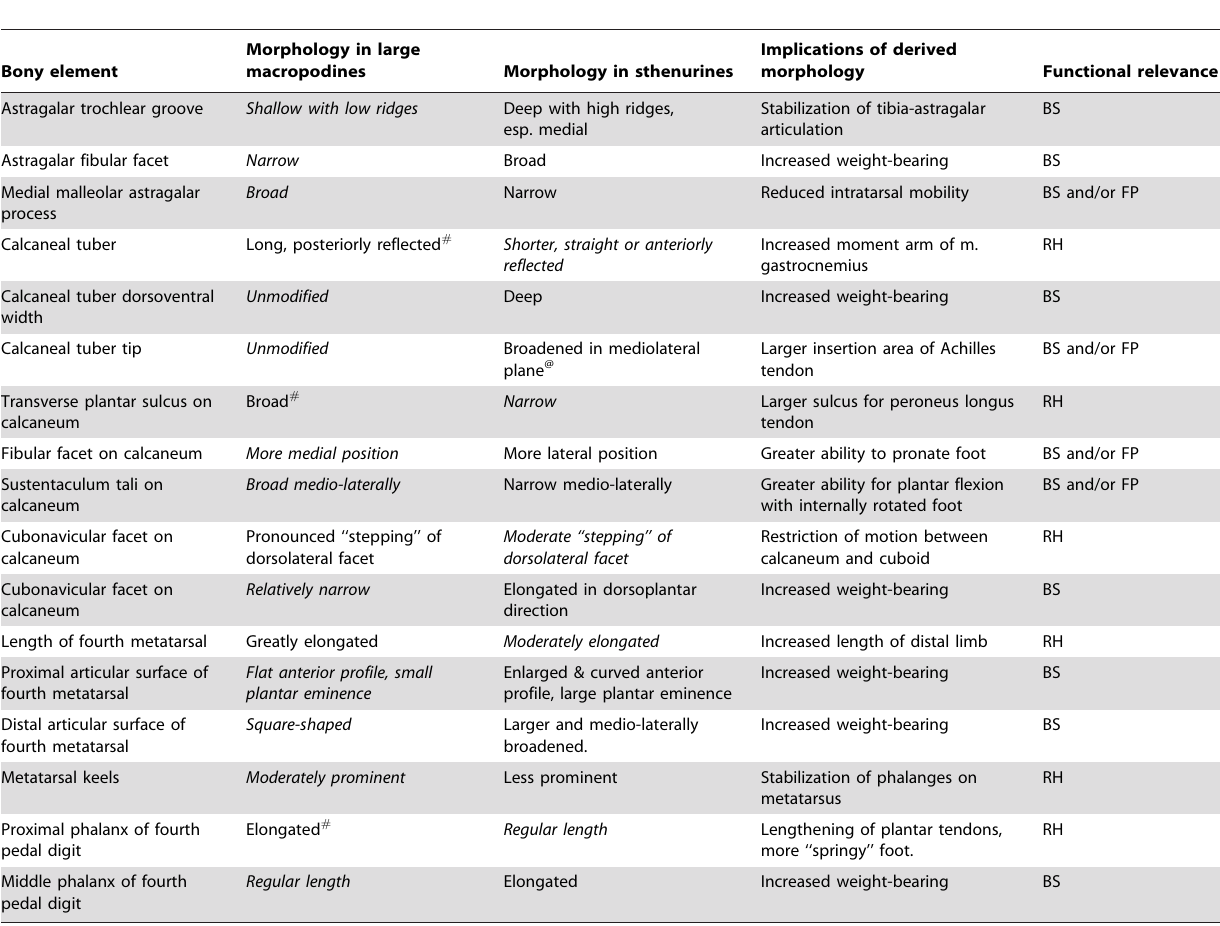
Table 7. Summary of important differences between sthenurines and large large species of Macropus II: Pes.